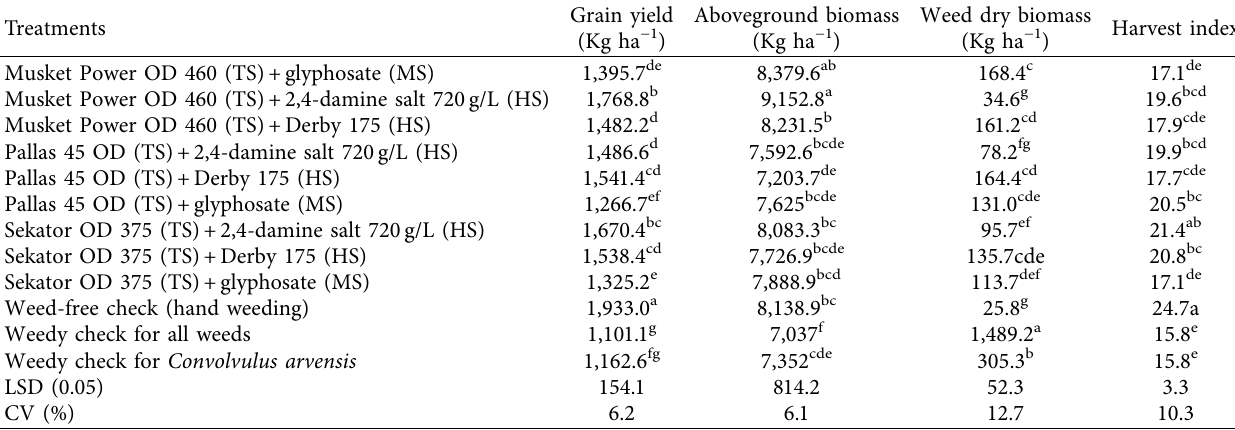
Table 3: Effects of weed control methods on grain yield, aboveground biomass, weed dry biomass and harvest index of tef (combined mean of 2020 and 2021